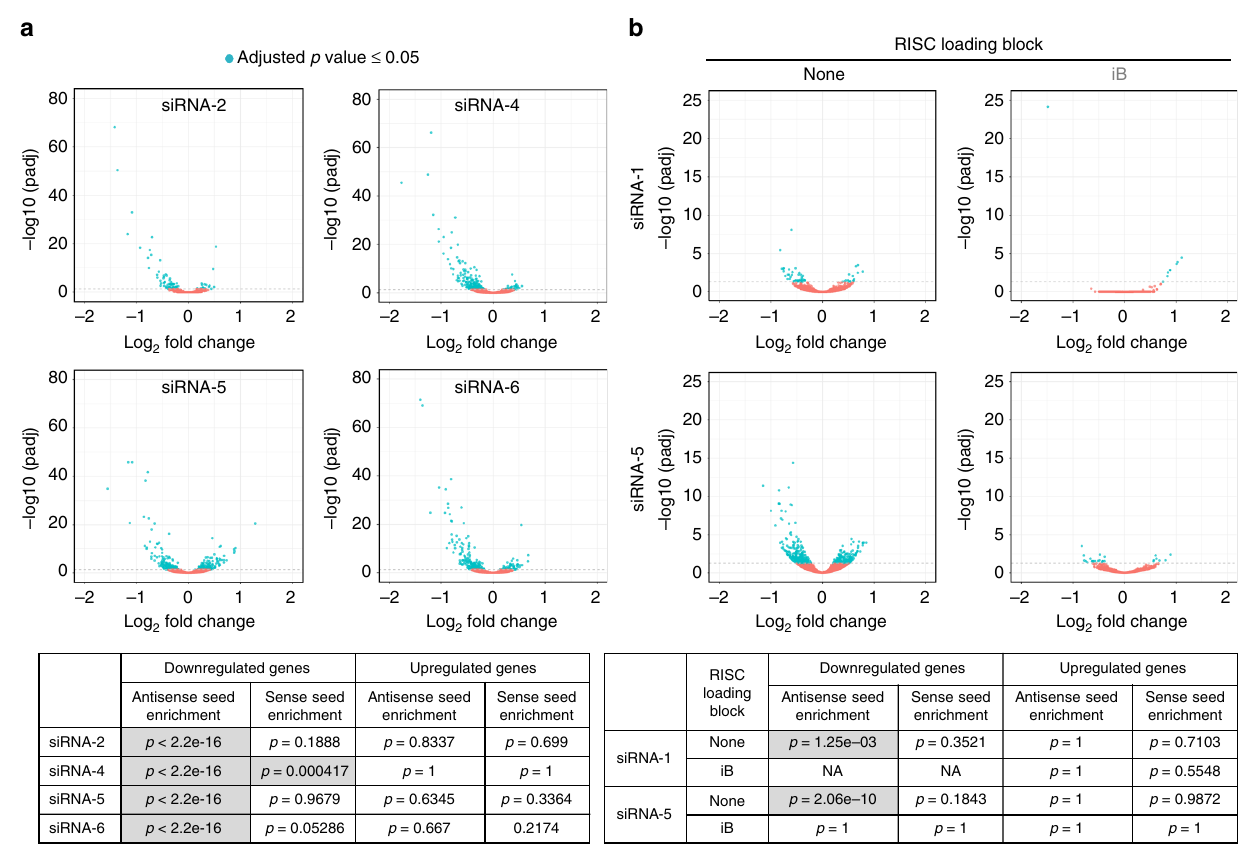
Fig. 5 siRNA off-targets are enriched for seed complementarity in vitro and in vivo. a Volcano plots depicting global gene expression changes in rat hepatocytes at 24 h after transfection with 10 nM of GalNAc-siRNAs of four different sequences. Enrichment of the seed region complementarity in 3 ′ UTRs is tabulated. N = 3 technical replicates. b Volcano plots depicting global gene expression changes in rat liver at 24 h after subcutaneous administration of GalNAc-siRNAs at 50 mg/kg. Two parent GalNAc-siRNAs and their RNAi-inactive versions blocked with inverted abasic (iB) caps are shown. Enrichment of the seed region complementarity in 3 ′ UTRs is tabulated. Blue points, adjusted p ≤ 0.05; red points, adjusted p > 0.05; N = 3 males (6 – 8 weeks old) per group. The adjusted p -value for fold change was calculate in DESeq2 using the Wald test with multiple test correction. Seed enrichment p -value was calculated using the Fisher ’ s exact test. The variance was similar between groups that were statistically compared. iB, inverted abasic; NA, not applicable ( p -values could not be calculated due to absence of downregulated